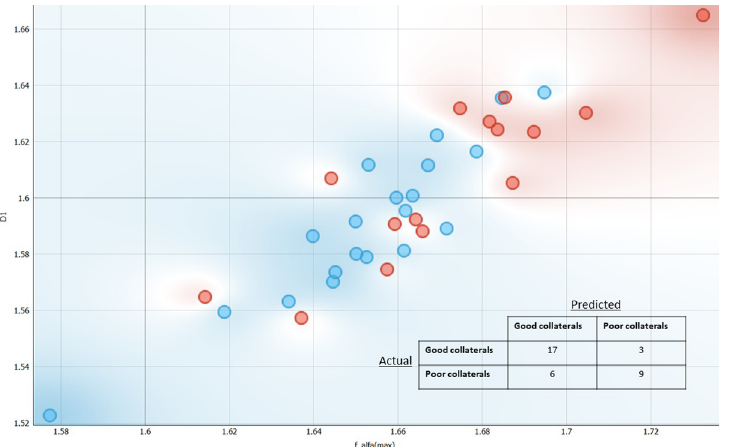
Fig 3. Scatterplot for the support vector machine learner and the corresponding confusion matrix based on leave- one-out cross validation of the classification. Patients with good collaterals are represented with blue circles and poor collaterals with red